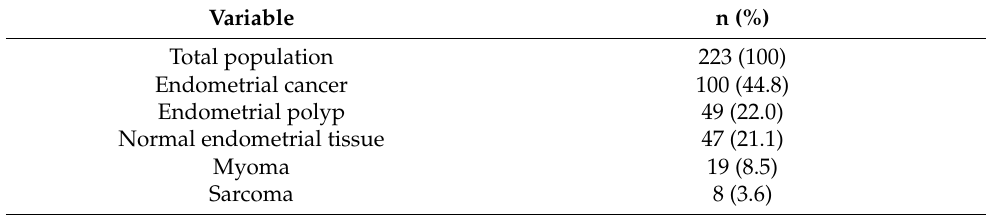
Table 1. Group characteristics.